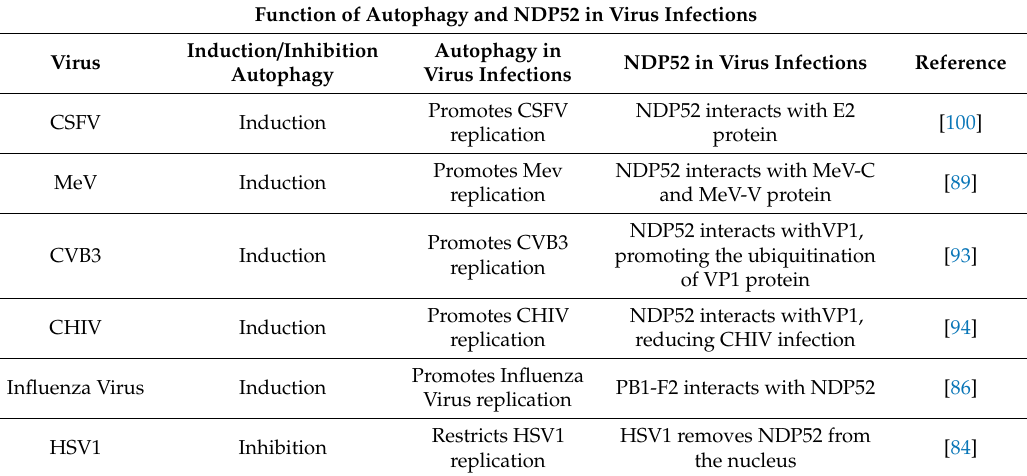
Table 2. Function of autophagy and NDP52 in virus